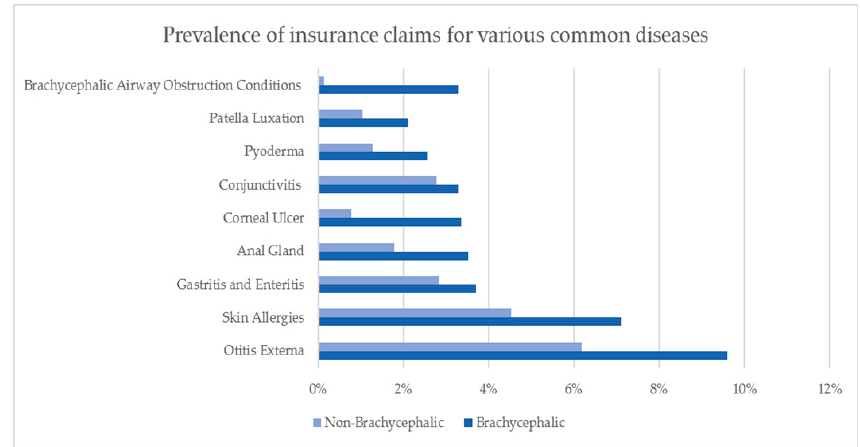
Figure 2. The prevalence of PetSure insurance claims relating to common diseases in brachycephalic and non-brachycephalic breeds from 2013–2017. and non-brachycephalic breeds from